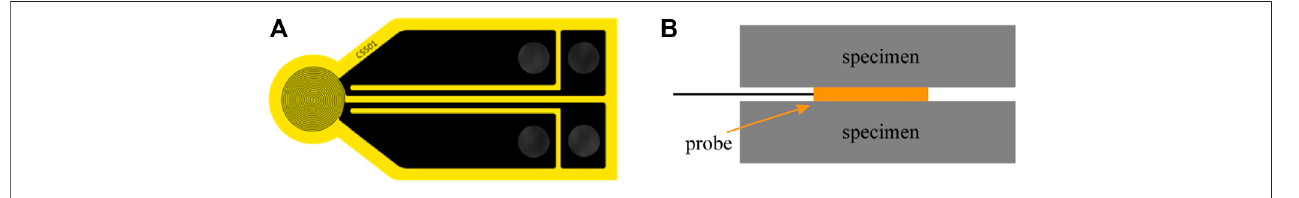
FIGURE 3 | Schematic diagram of thermal parameters by Hot Disk 2500S. (A) A thin disk-shaped temperature dependent probe; (B) The sandwich structure formed by the sample and the probe during